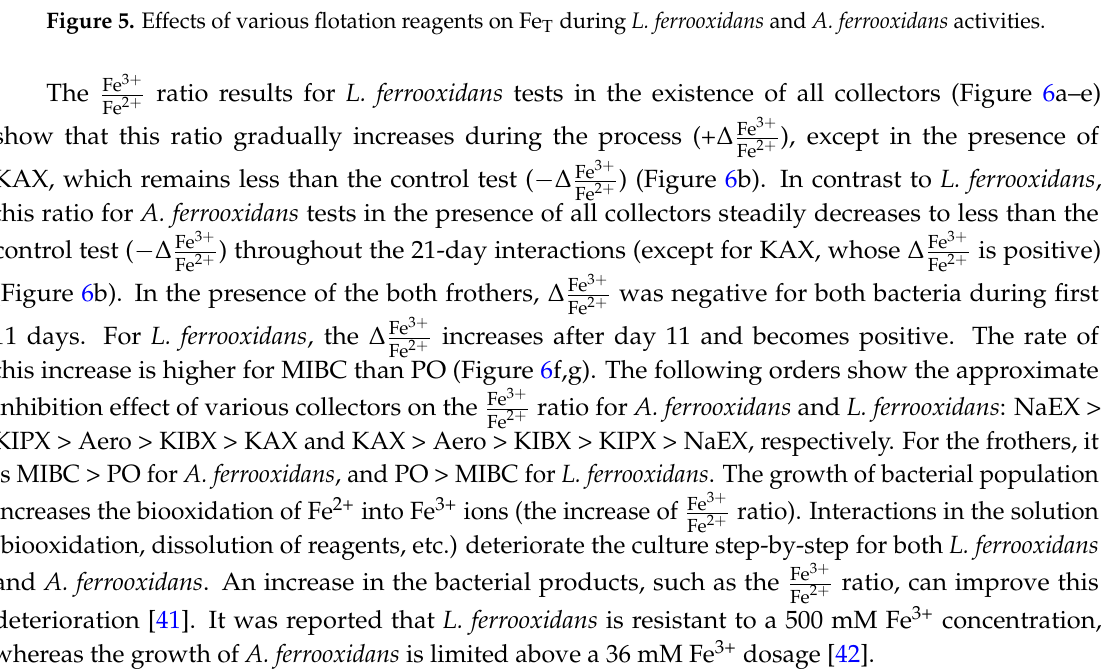
Fe during L. ferrooxidans and A. ferrooxidans T